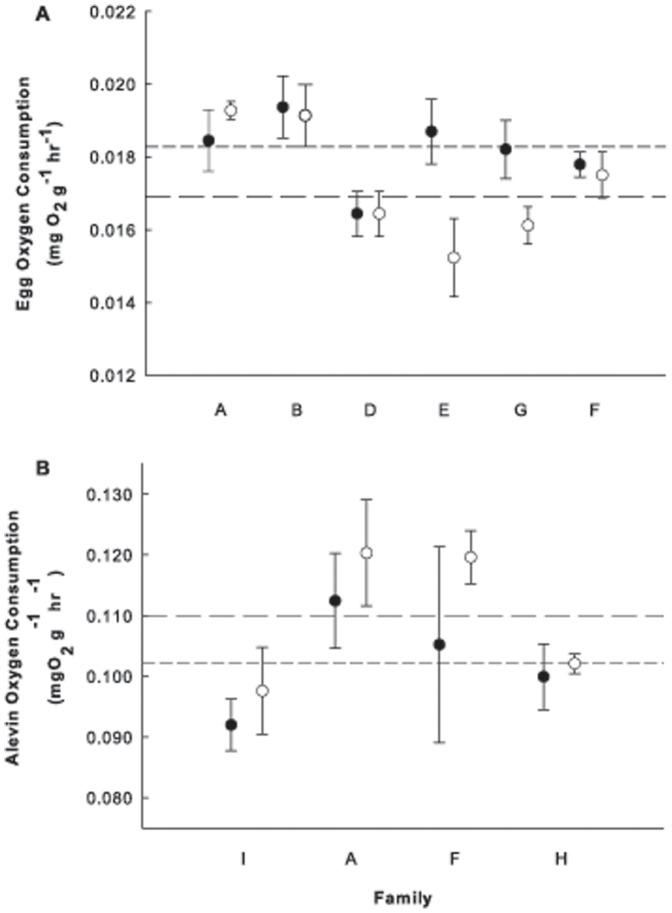
The mean (±S.E.) routine oxygen consumption (mg O2 g−1 hr−1) of transgenic and non-transgenic Atlantic salmon (Salmo salar) eyed-embryo (A) and alevin (B) full siblings.Transgenic and non-transgenic mean values within families are represented by black and white circles, respectively. The short and long dashed lines represent the overall transgenic and non-transgenic means, respectively.